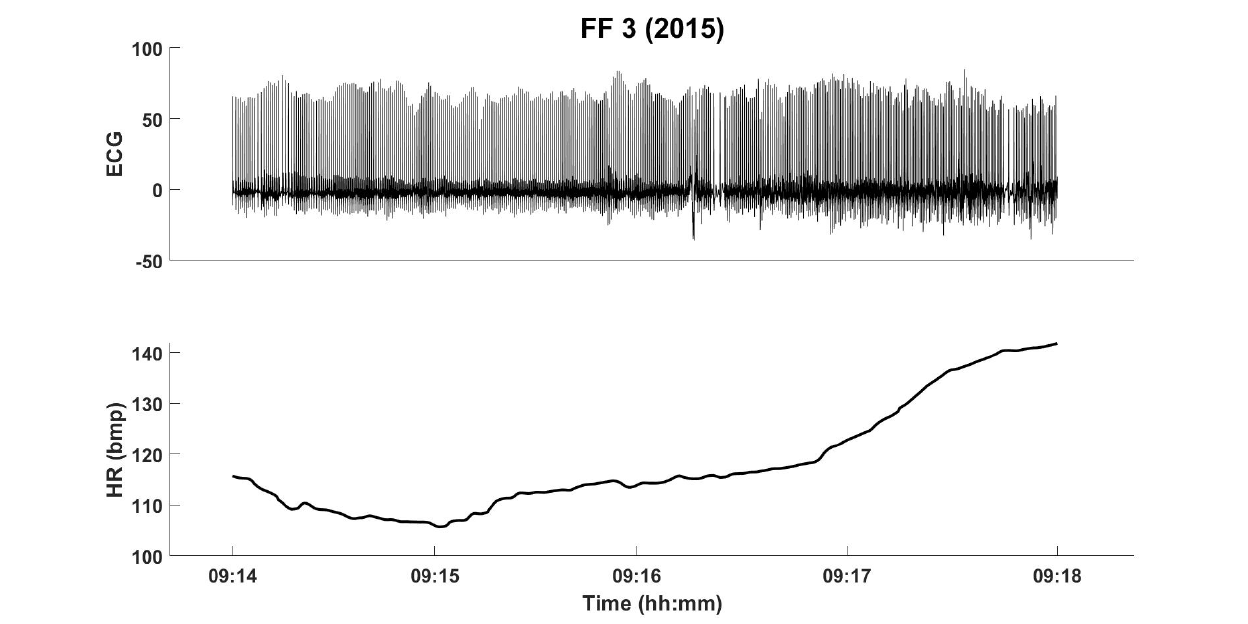
Figure 2. The filtered ECG and the HR for FF3, from the fire experiments in 2015 (for four minutes).